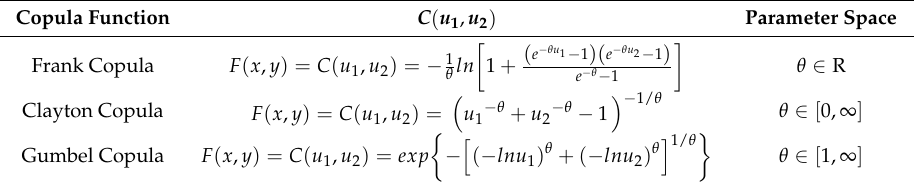
Table 1. Bivariate Archimedean copula function and parameter space. Copula